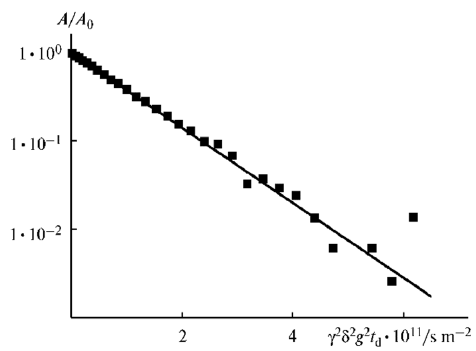
Figure 26. Diffusion decay on 7 Li for the composition of PE 5 [60].